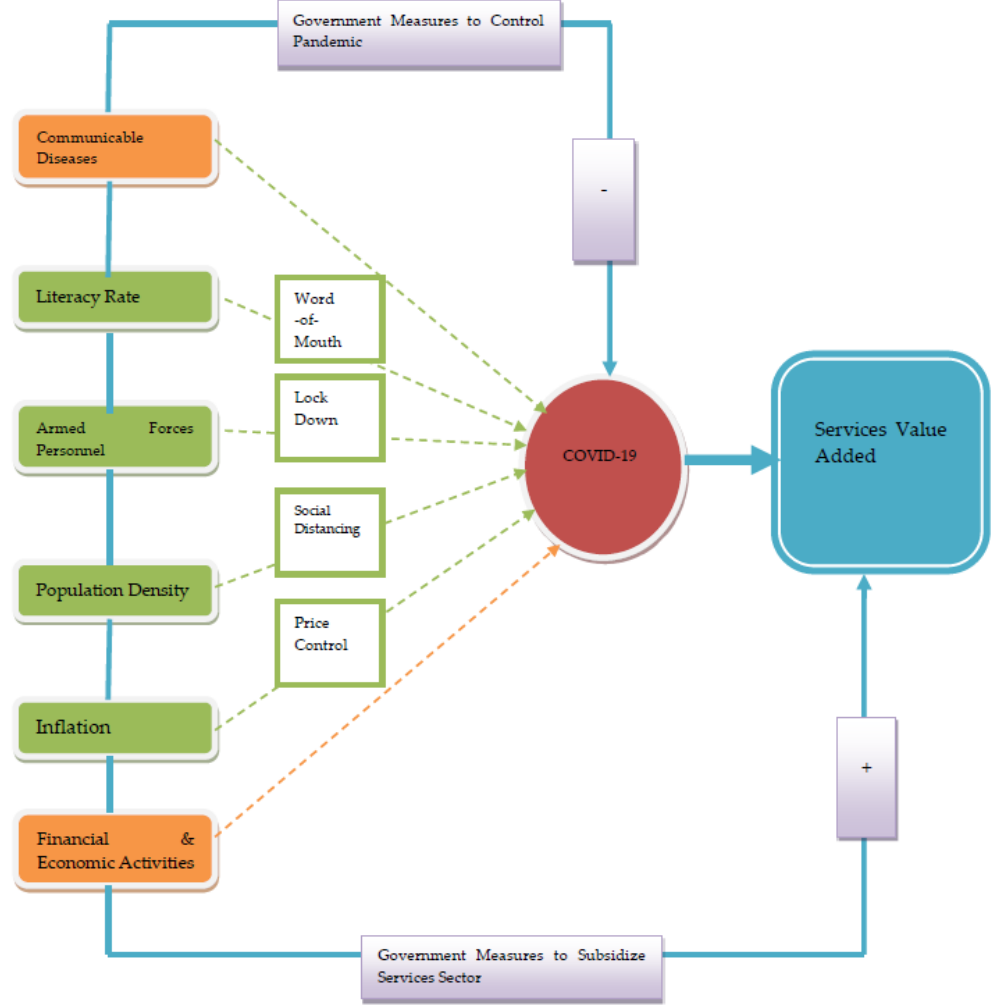
where τ 10 to τ 90 show quantiles regression estimates from 10th quantiles to 90th quantile distribution.